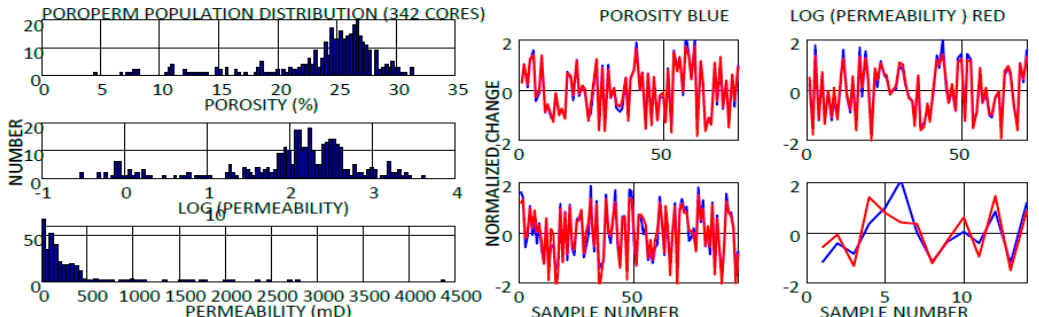
Figure 2. Porosity and permeability measurements on four sub-vertical North Sea gas field well cores. ( Left panel ) Histograms of porosity values are plotted as number of values in 1% wide bins versus percent porosity. Both log permeability and permeability data are plotted as the number of values in a bin versus millidarcies. The histograms suggest that the porosity has a normal, and the permeability a lognormal, distribution. ( Two right panels ) Porosity (blue) and natural ln permeability (red) data are plotted as functions of sample number. The porosity and permeability data are normalized to zero mean and unit variance.